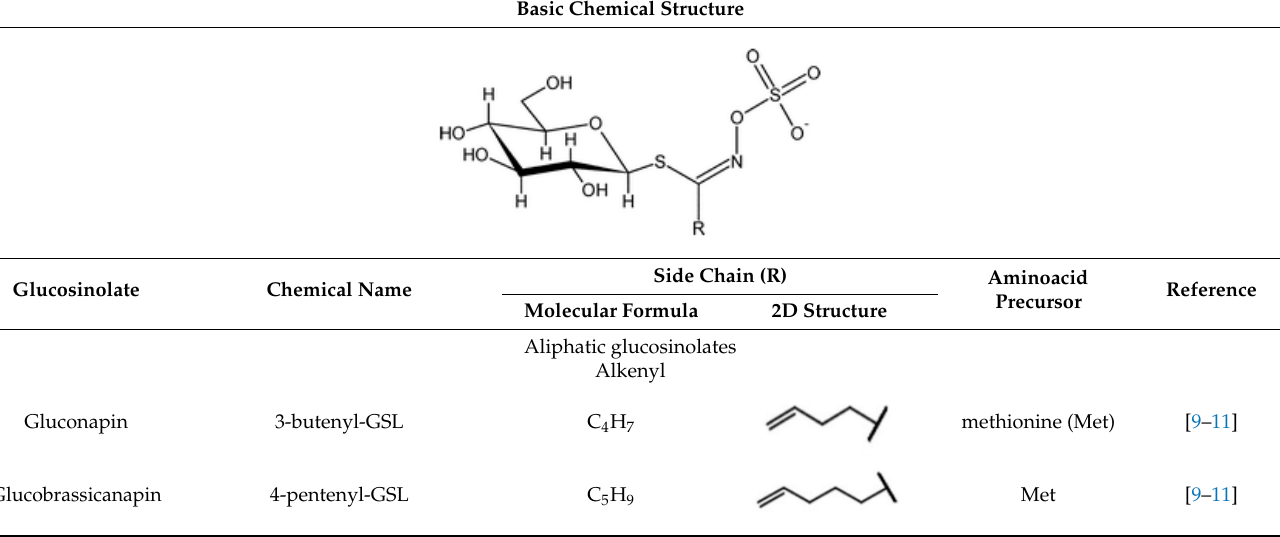
Table 1. Basic chemical structure of those glucosinolates (GSL) analyzed in the frame of intervention studies or clinical trials and the association between precursor amino acids and individual GSL with detail of the chemical structure of the side chain (R).